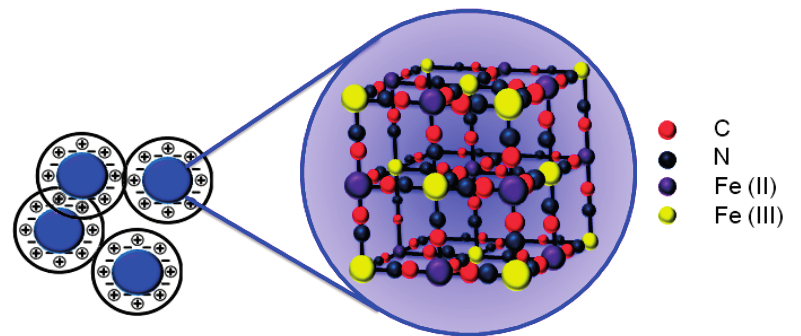
Figure 1. Schematic representation of Prussian blue nanoparticle lattice